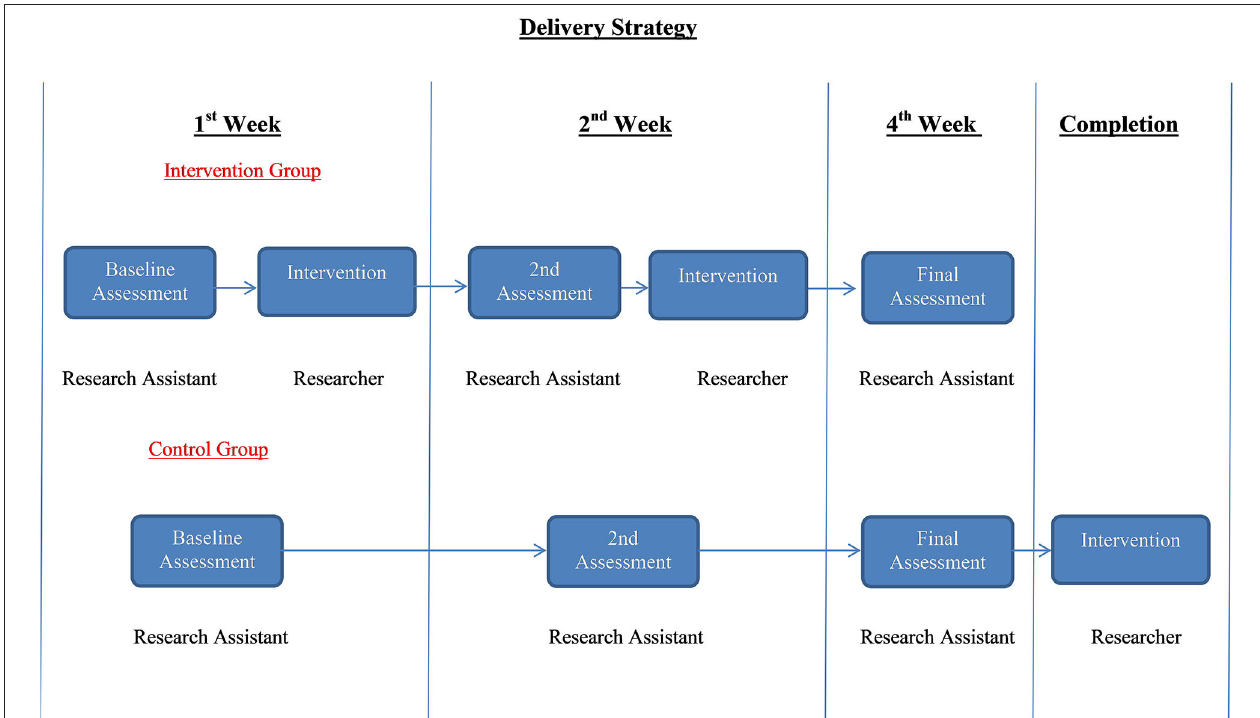
FIGURE 1 | Study delivery